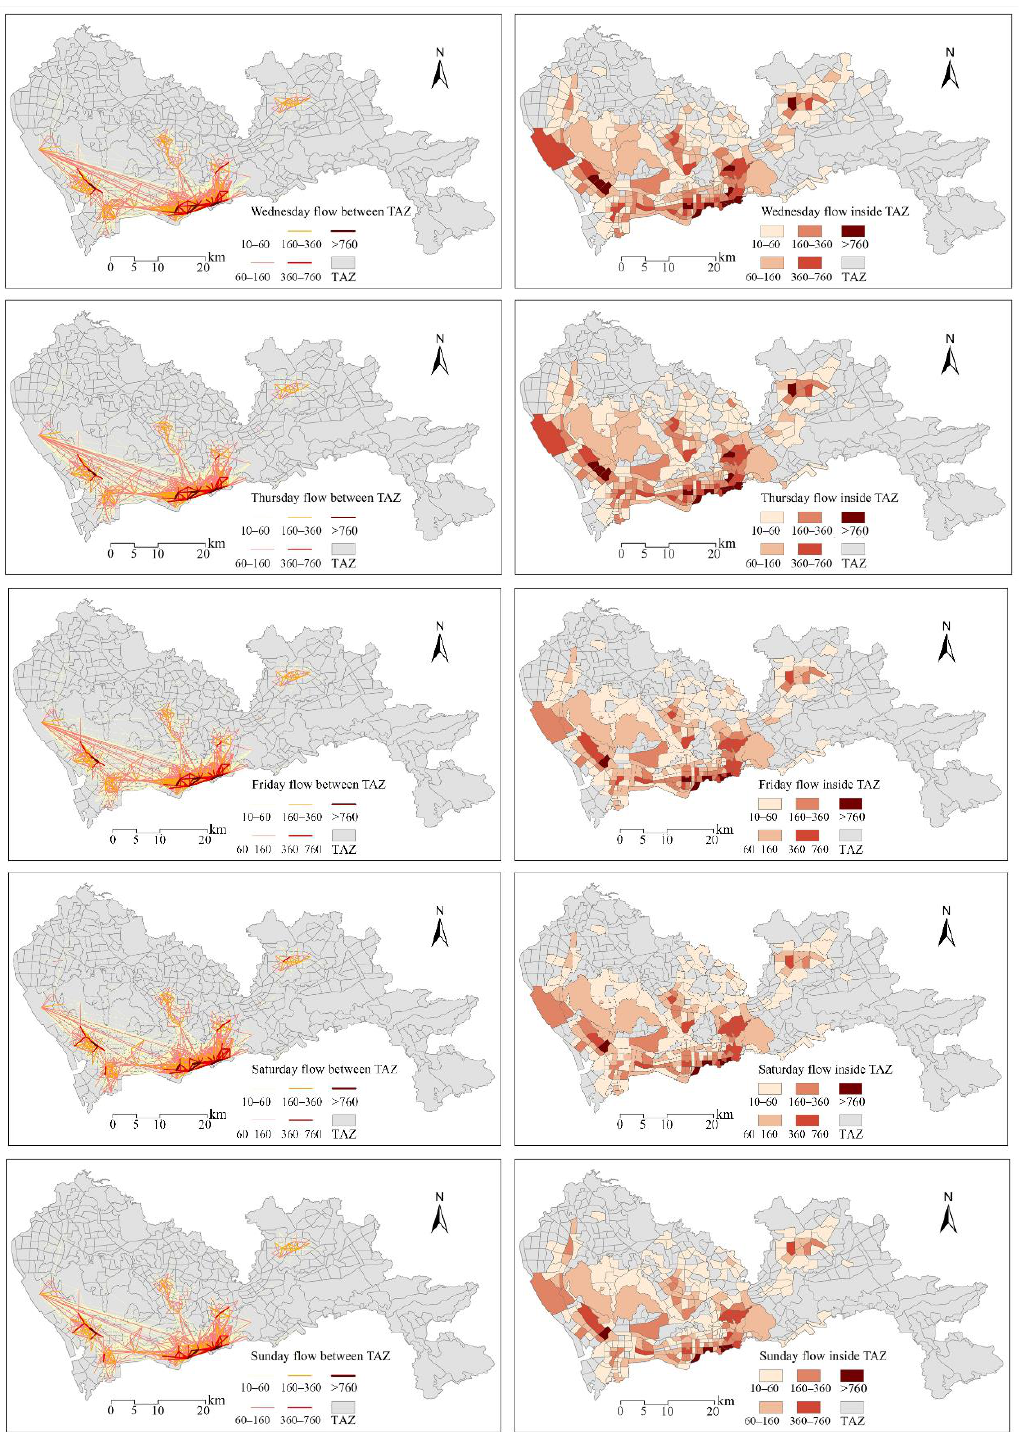
Figure A3. Travel spatial structure diagram from Monday through Sunday in Shenzhen.